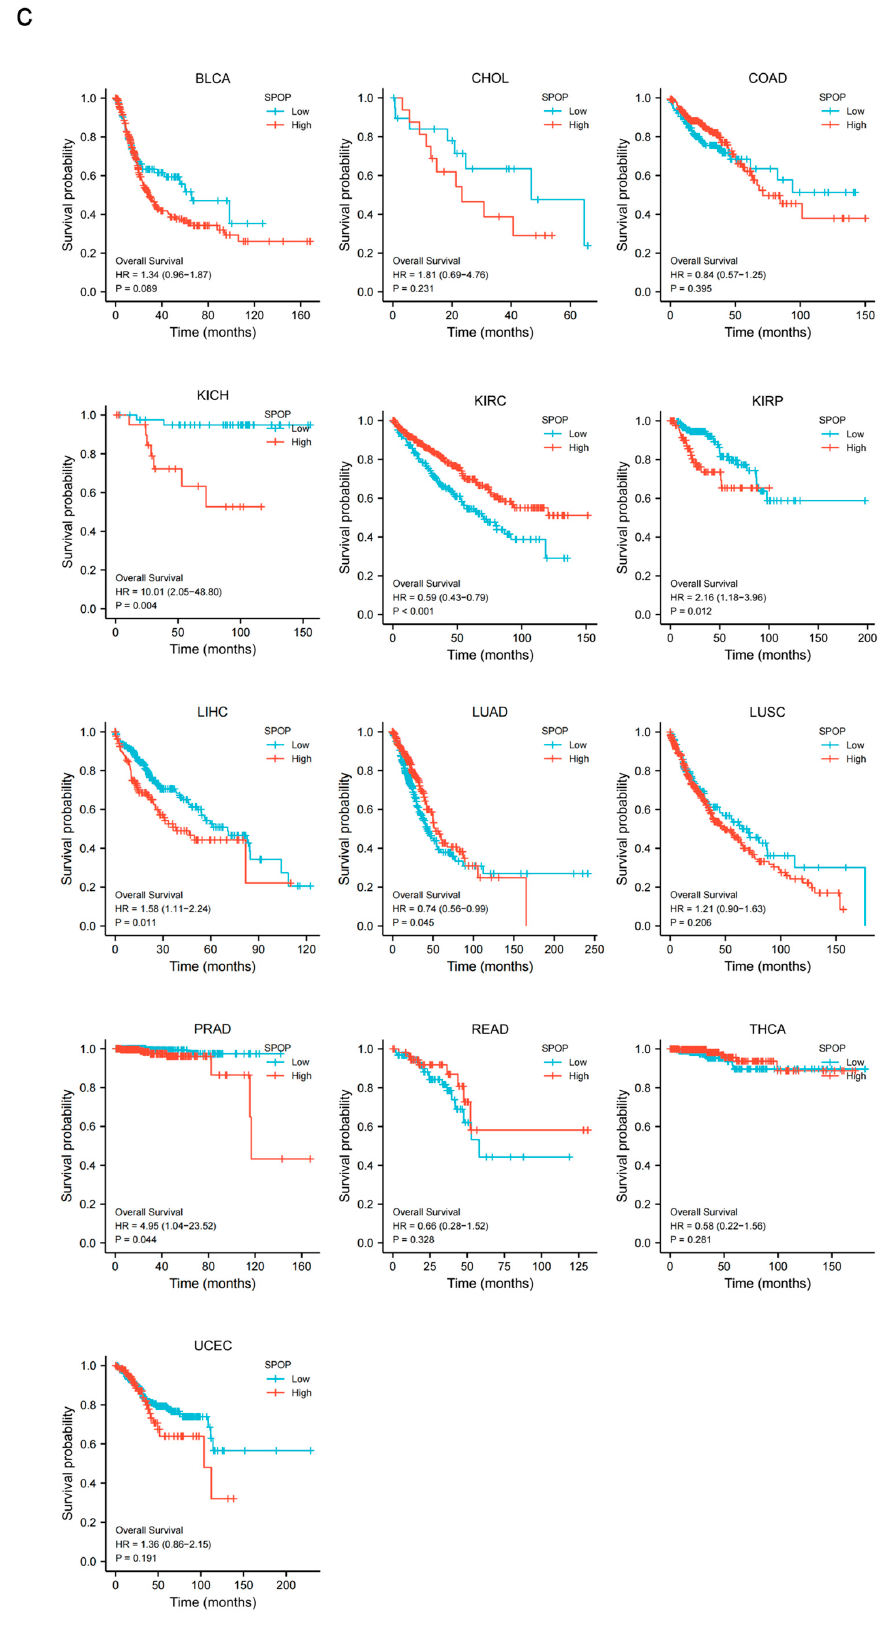
Figure 2. SPOP mRNA expression in different cancers. ( a ) A graph showing the levels of SPOP mRNA expression levels in a variety of cancers along with corresponding normal controls;